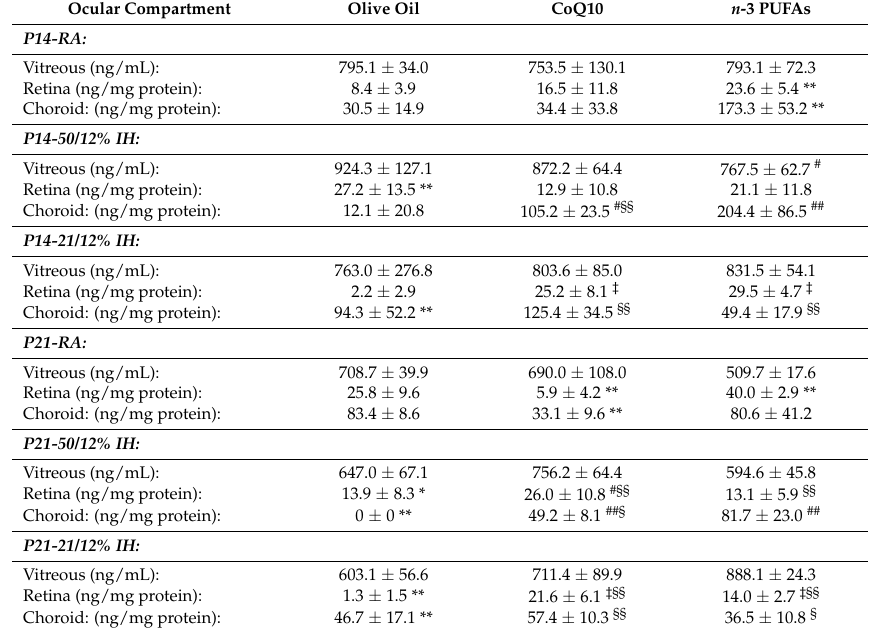
Table 3. Ocular IGF-I.